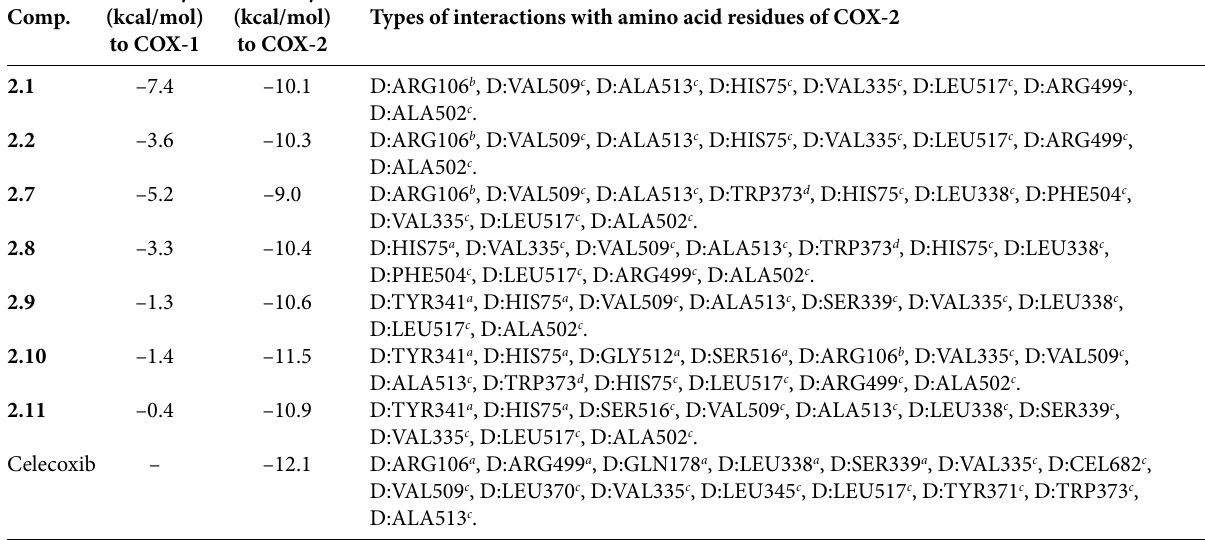
Table 1. Results of molecular docking of the most active structures Affinity Affinity